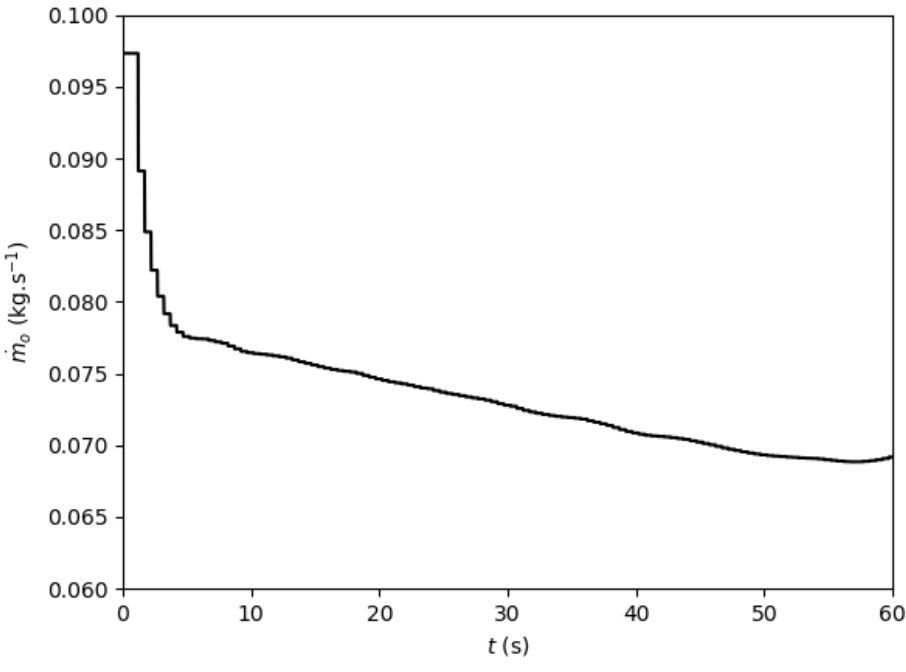
Figure 32. Oxidizer mass flow rate profile, feedback with complete regulation law, case 3.